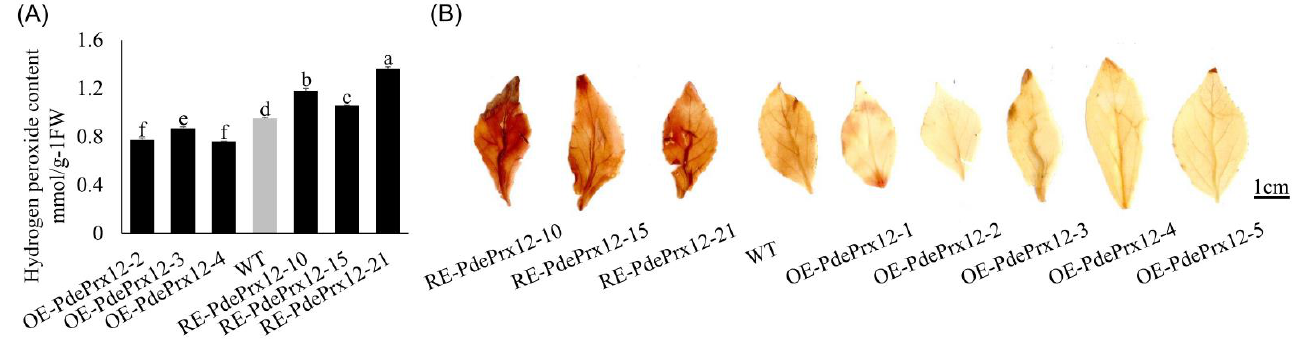
Figure 4. Phenotypes of the PdePrx12 transgenic lines. ( A ) Determination of H 2 O 2 content in OE/RE- PdePrx12 and WT lines (mmol/g FW). Determination of H 2 O 2 content in OE/RE-PdePrx12 and WT lines. The content of H 2 O 2 in WT was set to 1. The letters in the figure indicate differences based on multiple comparisons ( p = 0.05). ( B ) DAB staining of OE/RE-PdePrx12 and WT leaves (bar = 1 cm). ( C ) Phenotypic observation of OE/RE-PdePrx12 and WT under the infection of pathogen 3C on the 7th day (bar = 1 cm). ( D ). Phenotypic observation of OE/RE-PdePrx12 and WT under the infection of pathogen 3E on the 14th day (bar = 1 cm). ( E ) The mean values of the infected area of leaves of OE, RE and WT lines by pathogen 3C were statistically analyzed by Image-Pro Plus image pro- cessing software. The letters in the graphs indicate differences based on multiple comparisons ( p = 0.05). ( F ) The mean values of the infected area of leaves of OE, RE, and WT lines by pathogen 3E were statistically analyzed by Image-Pro Plus image processing software. The letters in the graphs indicate differences based on multiple comparisons ( p = 0.05). 4.5. The PdePrx12 Gene Negatively Regulates Disease Resistance in Poplar The above selected transgenic lines were grown in soil for 2 months and inoculated with the 3C/3E pathogens. After 10 days of dark incubation, it was observed that the leaves of the OE line were infected with pathogen 3C up to the margins (Figure 4C), and compared to the WT, all the OE lines were extensively infected with pathogen 3C, whereas